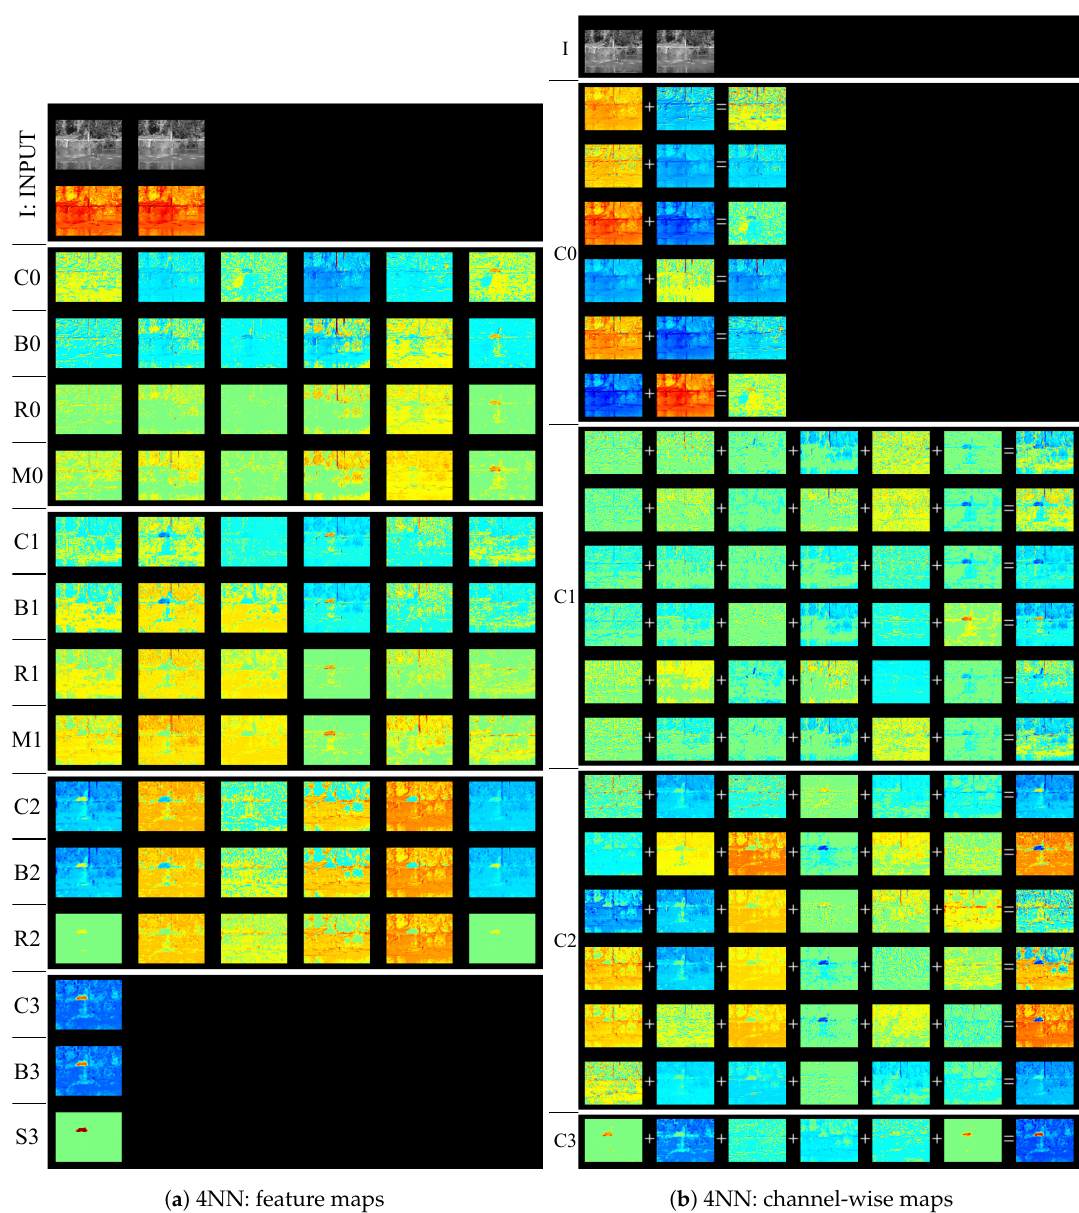
Figure 6. Visualization of feature maps in 4NN trained on fountain02 sequence. We visualize feature maps in each sub-layer and channel-wise convolution as in Figure 1. The abbreviations C, B, R, S, and M mean convolution, bias, ReLU, sigmoid, and max-pooling layer,